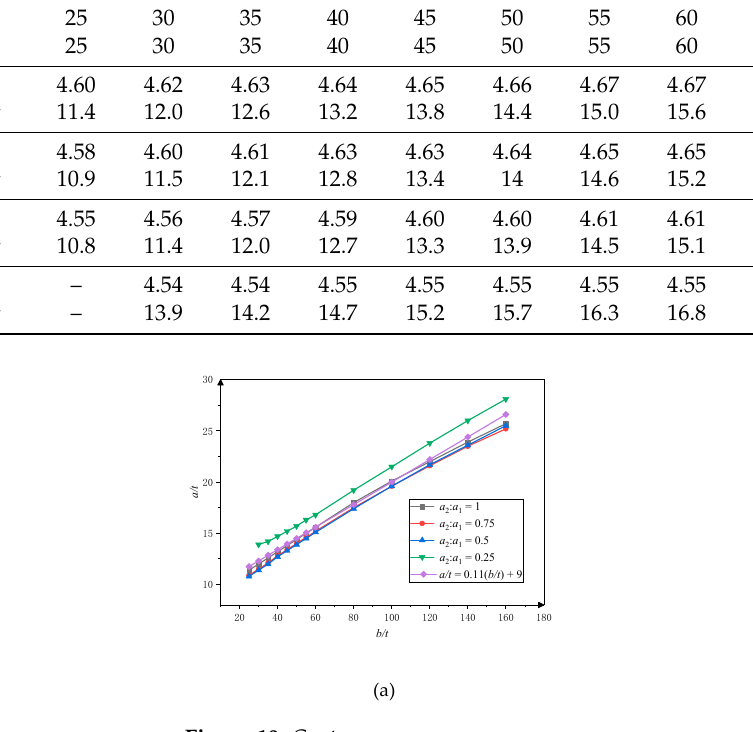
Table 3. Values of a/t when k = Table 2. Values of a/t when l/t = b/t .